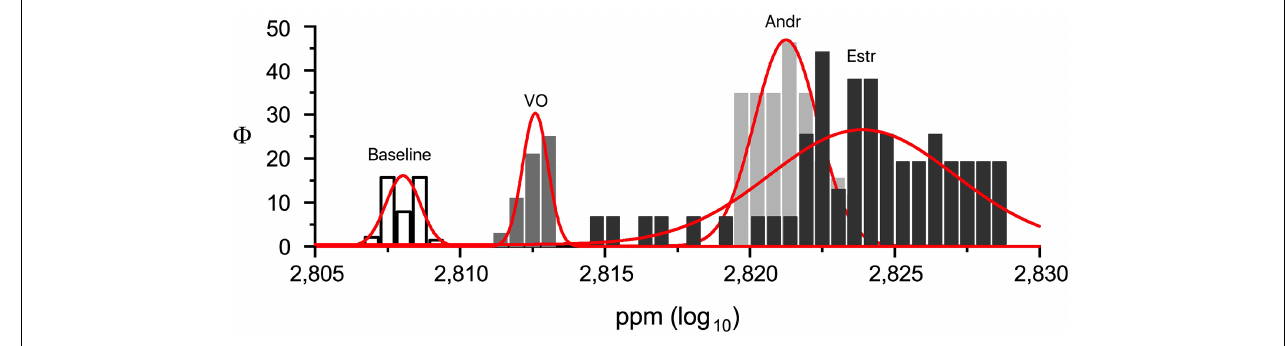
FIGURE 3 | Statistical box and whiskers graphs showing real time of embodied media (EBM) and EBM conditioned with VO, Andr, and Estr recordings.